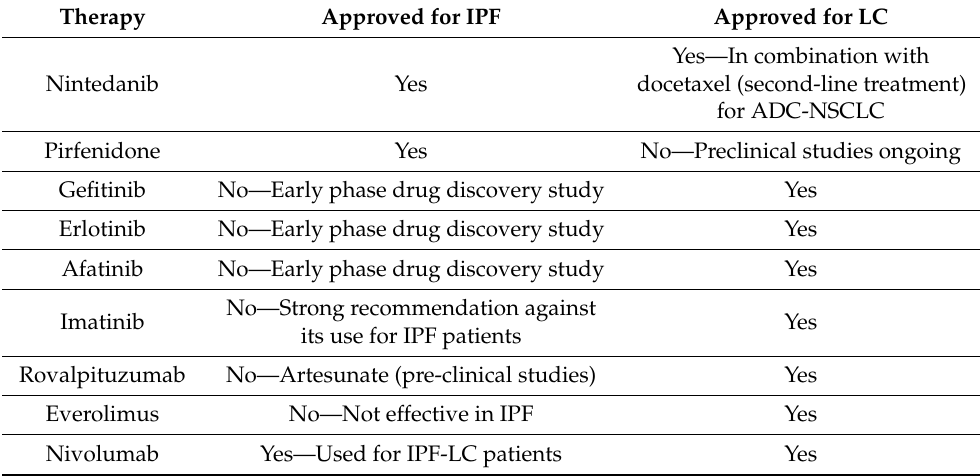
Table 1. Current approved therapeutic strategies for IPF and LC